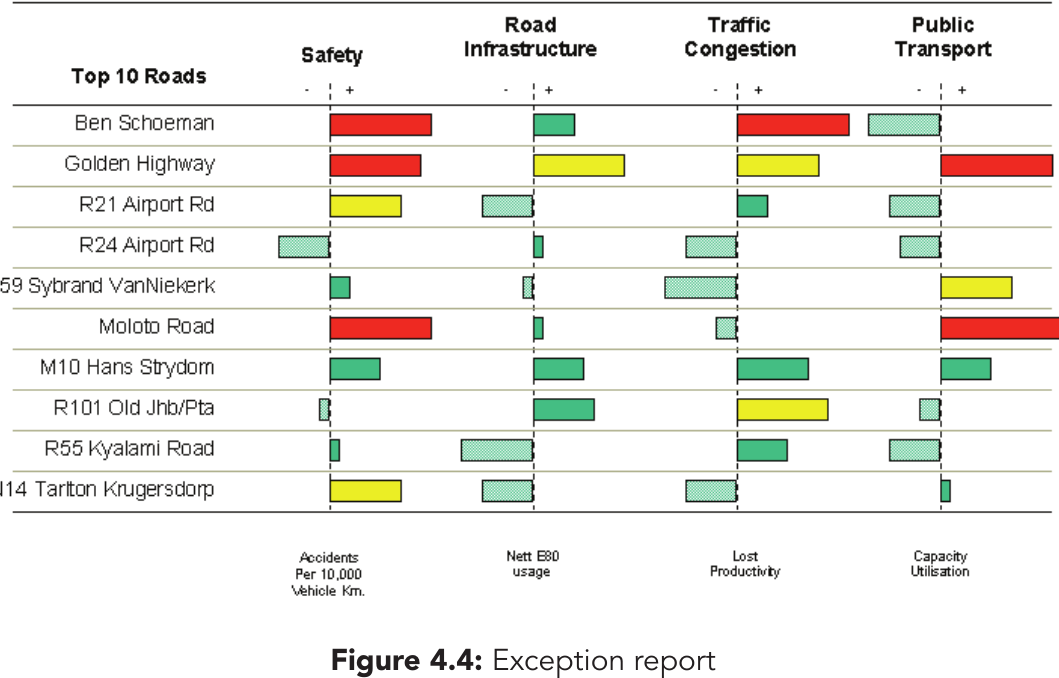
Figure 4.4: Exception report (for demonstration purposes